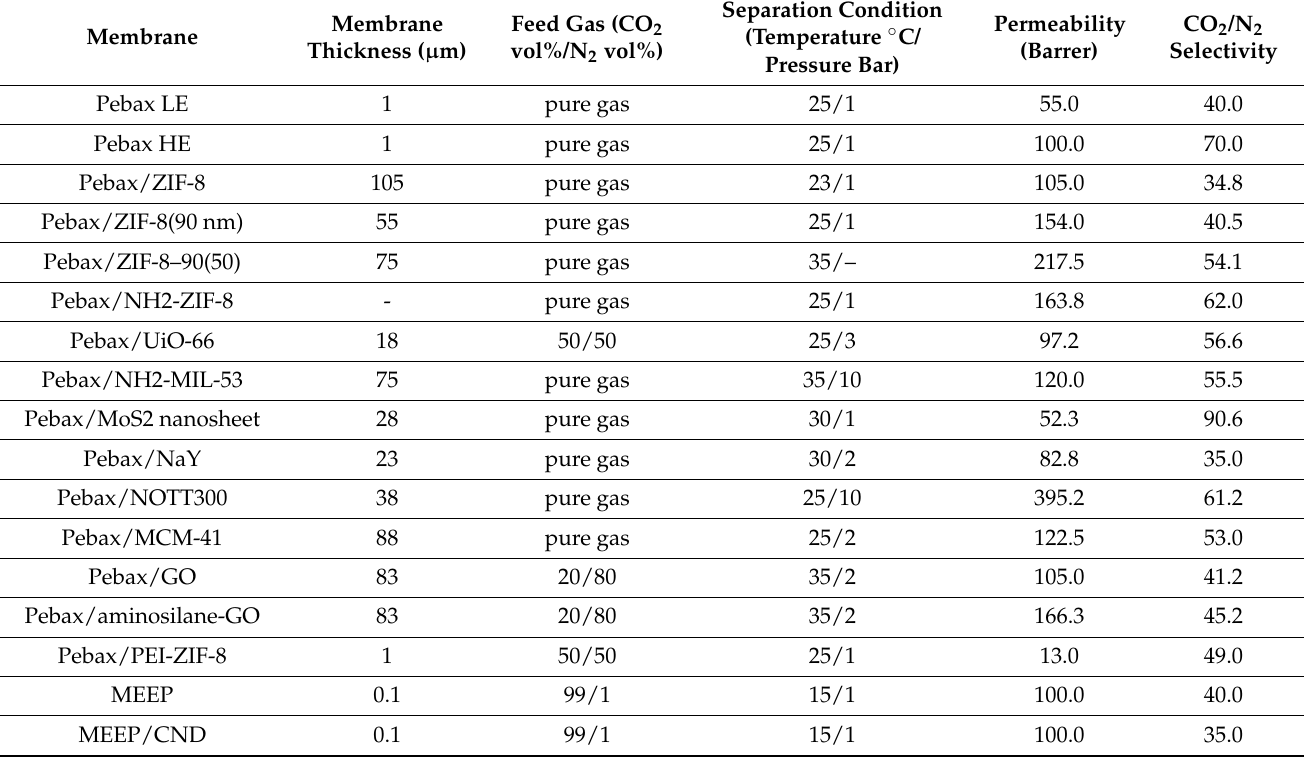
Table 1. Membranes studied in this manuscript [61]